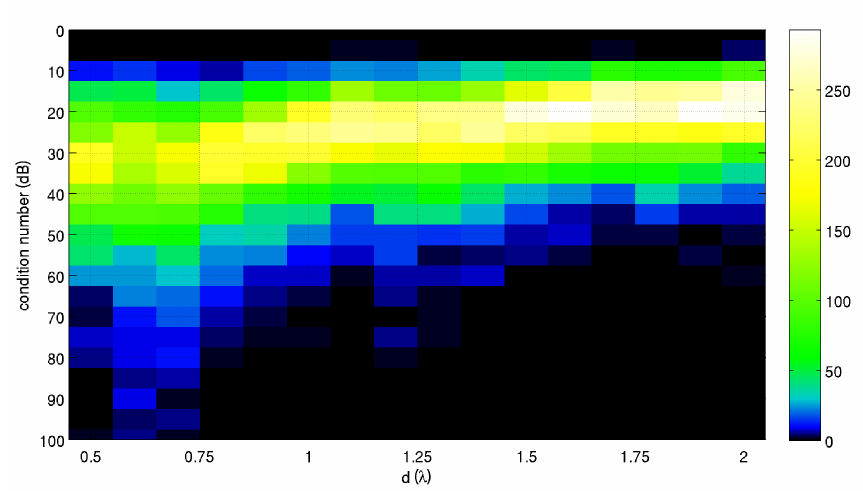
Figure 7. Distribution of the condition number as a function of the distance d for K = 50. Each column of the matrix in the image map is a histogram of the condition number.